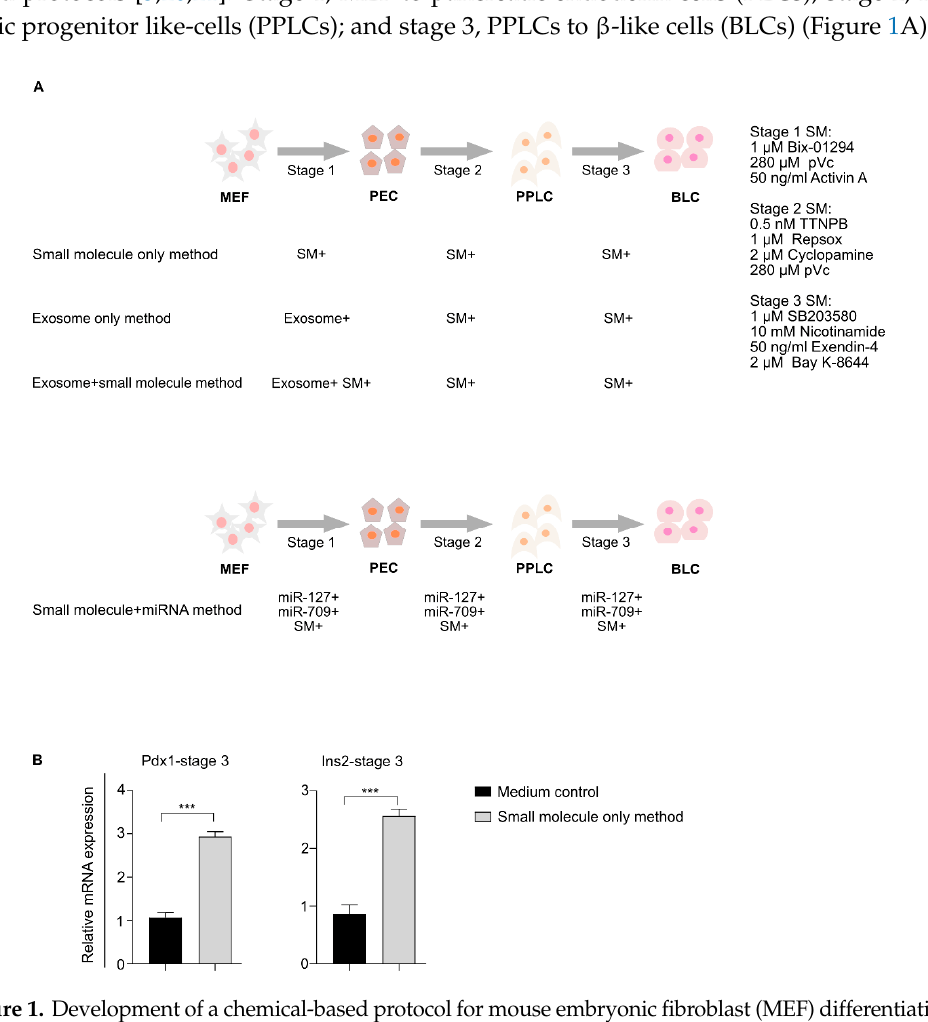
Figure 1. Development of a chemical-based protocol for mouse embryonic fibroblast (MEF) differentiation. ( A ) Schematic diagram representing a new small molecule-based method for di ff erentiating MEFs